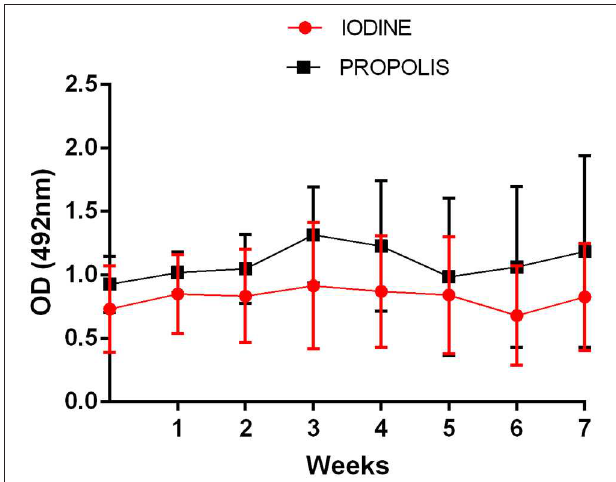
FIGURE 7 | Production of anti- C pseudotuberculosis specific antibodies in animals treated with iodine or green-propolis-based ointment. Data are shown as mean of the optical densities (OD) values, and bars represent their respective standard deviations. No statistical differences by the Student t -test ( p < 0.05) were found between the two groups at the same collection time.